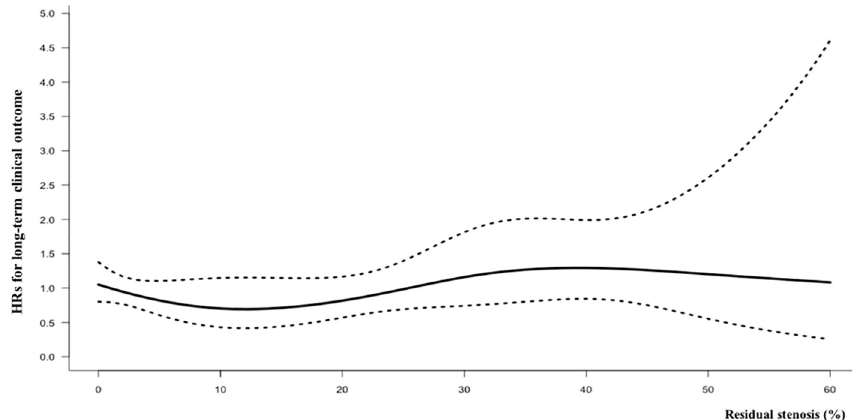
Fig 3. The adjusted hazard ratios of residual stenosis for clinical outcome. The solid line indicates the hazard ratio, and the dotted line indicates the 95% confidence interval. HR, hazard ratio.